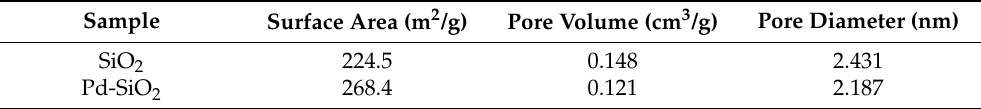
Table 2. The textural properties of bare SiO 2 and Pd-SiO 2